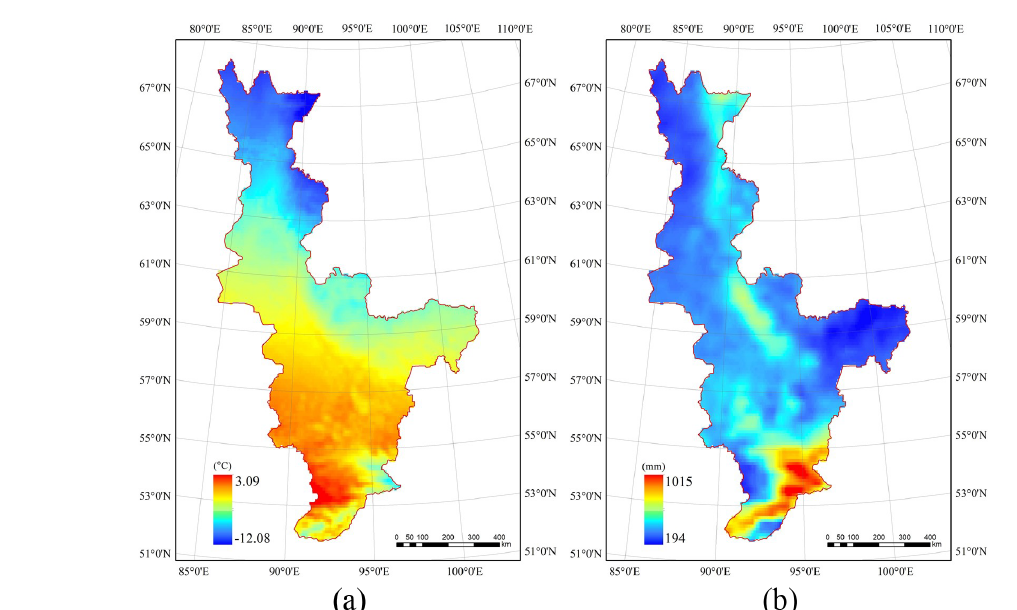
Figure 10. (a) Average temperature and (b) total precipitation in the study area for the year 2000.